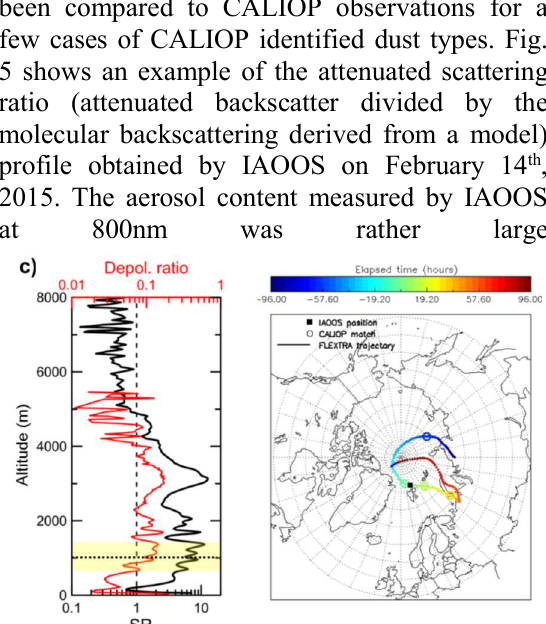
Fig. 5: Left:: Attenuated backscatter ratio (SRatt) and pseudo-depolarization ratio vertical profiles measured by IAOOS lidar at 800 nm on February 14 th , 2015. The horizontal dotted line indicates the altitude at which the FLEXTRA backward and forward trajectories were performed, while the yellow band shows the vertical interval (±0.5 km) used for CALIOP data analysis. Right: Map showing the 4 days backward and forward FLEXTRA